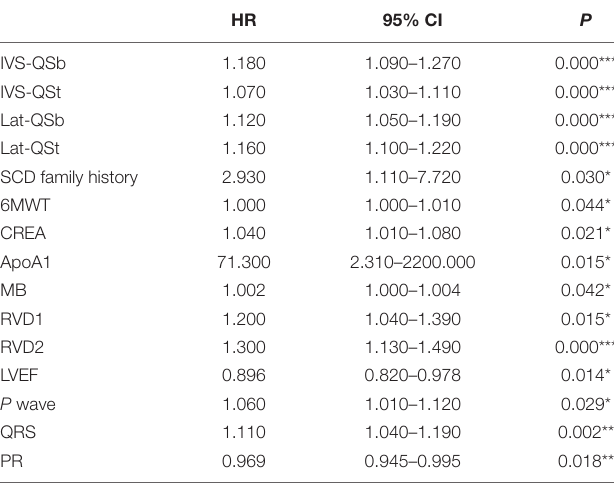
TABLE 2 | Univariate Cox analysis for